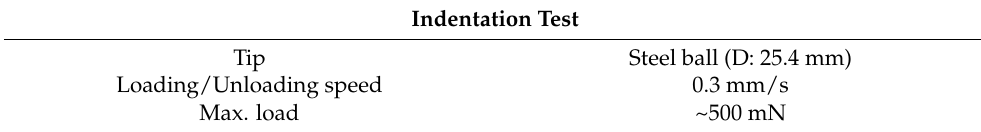
Table 1. Indentation test